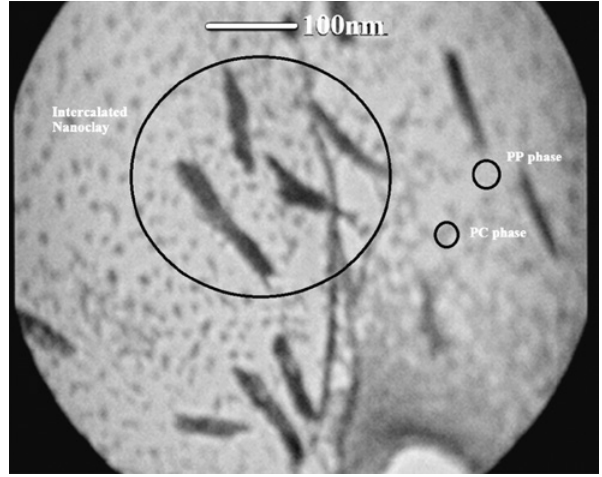
Figure 6: TEM image of PP/PC nanocomposites with 10 wt% PC and 5 wt%